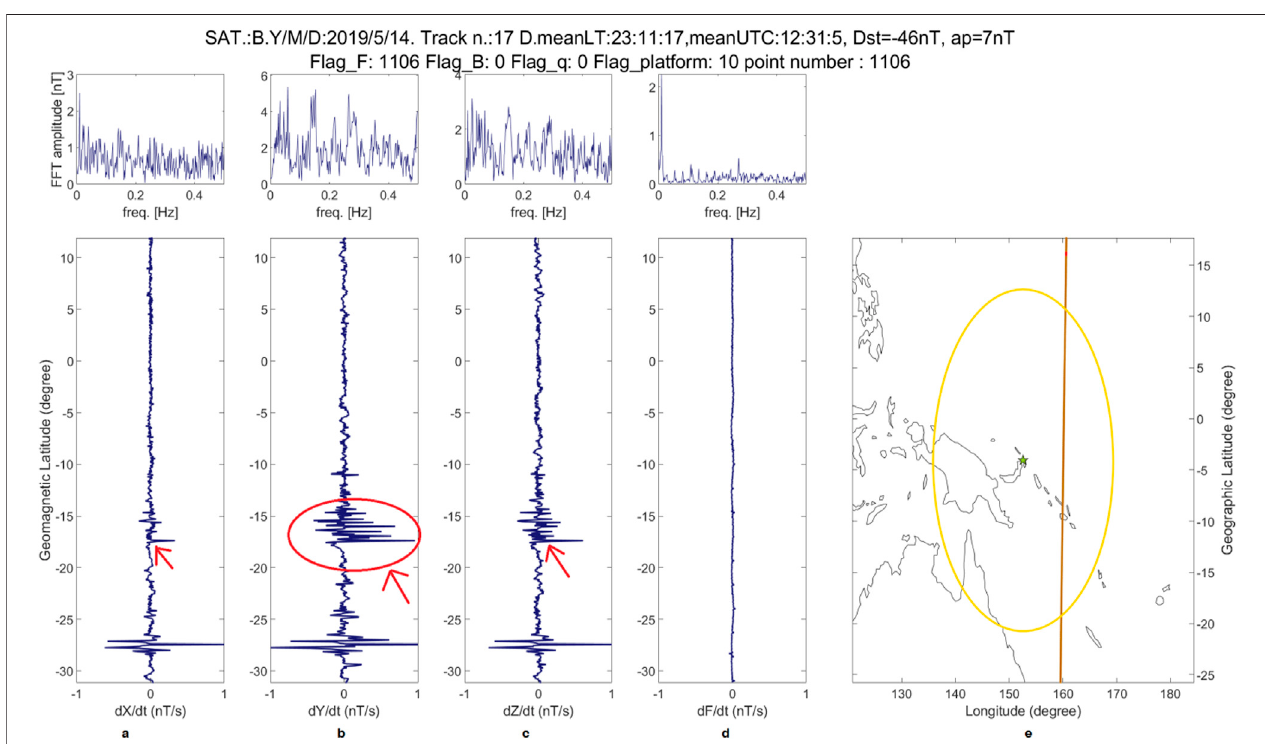
FIGURE 6 | Results of Swarm B track analysis for the New Guinea earthquake (May 14, 2019) on earthquake day. (E) A map of the region with the longitude in horizontal axis and latitude in vertical one is represented. A green asterisk, a brown line, and a yellow circle represent the earthquake epicenter, the track, and Dobrovolsky ’ s area, respectively. The track crossed the Dobrovolsky ’ s area between the 12:27:12 and 12:35:03 UTC. (A – D) The residuals of the time series of the derivatives of the measured scalar magnetic fi eld (X, Y, Z) components and F, respectively, along this track. The vertical axis represents the geomagnetic latitude. Above each analysis, the FFT spectra are represented